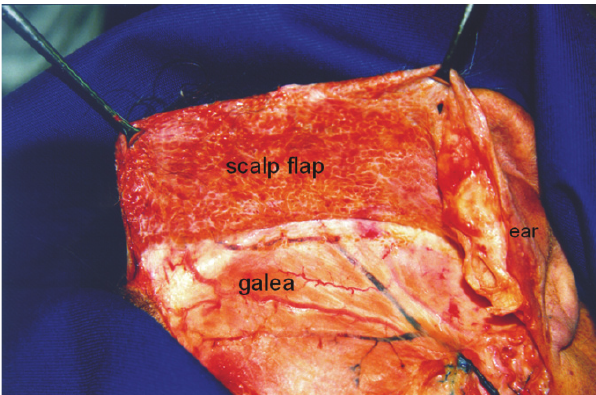
Figure 1 - Subfollicular dissection of the scalp exposing the temporoparietal galea and the superficial temporal vessels filled with latex. The external auditory canal is cut and the ear is reflected